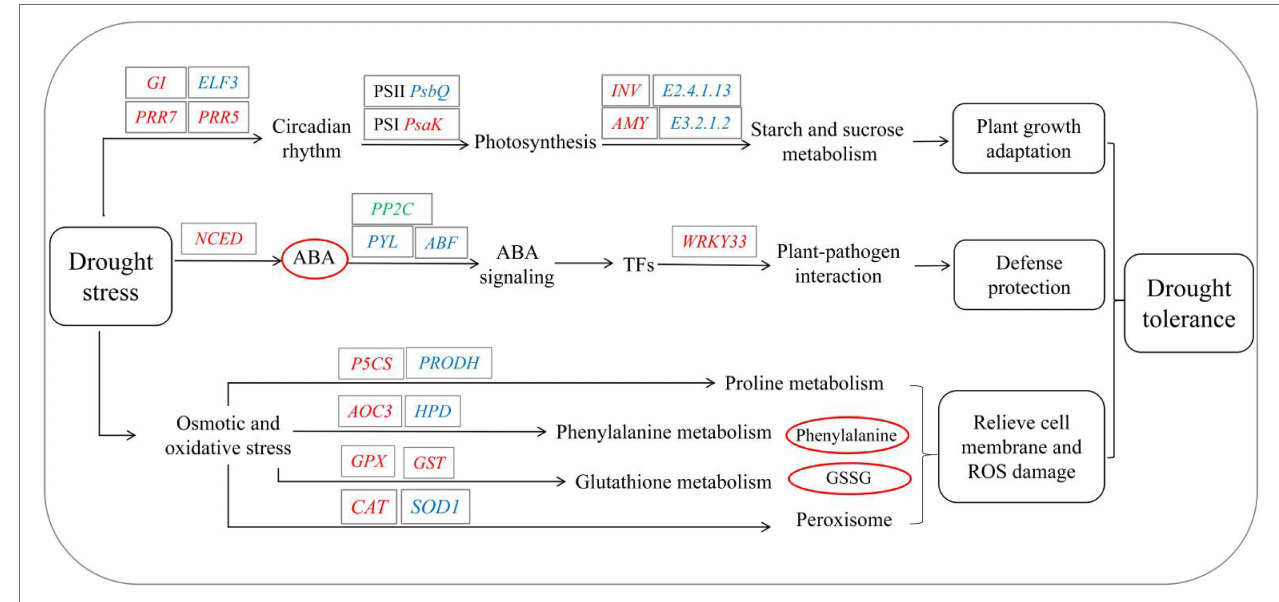
FIGURE 10 | Theoretical molecular mechanism in S. davidii in response to drought stress. E3.2.1.2 , beta-amylase; E2.4.1.13 , sucrose synthase; INV , beta- fructofuranosidase; AMY , alpha-amylase; GPX , glutathione peroxidase; NCED , 9-cis-epoxycarotenoid dioxygenase; PRR7 , pseudoresponse regulator 7; PRR5 , pseudoresponse regulator 5; ELF3 , protein EARLY FLOWERING 3; GI , GIGANTEA; SOD1 , superoxide dismutase; CAT, catalase; PRODH , proline dehydrogenase; P5CS , delta-1-pyrroline-5-carboxylate synthetase; WRKY33 , WRKY transcription factor 33; psbQ , photosystem II oxygen-evolving enhancer protein 3; and psaK , photosystem I subunit X. The genes in red, blue or green letters refer to up-, down- and both up- and downregulated expression, respectively, in response to drought. The metabolites in red or blue circles refer to those whose accumulation increased or decreased, respectively, in response to